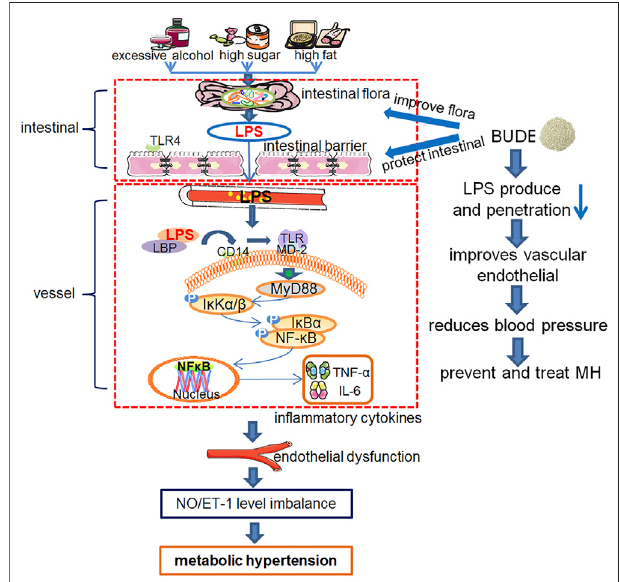
FIGURE 9 | Experiment protocol blueprints. This schematic diagram showsthemechanismofover-consumptionofalcohol,andhighsugarandfat diets (ACHSFDs) leading to metabolic hypertension (MH). BUDE regulated intestinal fl ora and improved the intestinal barrier, so as to reduce LPS production and in fi ltration into the blood circulation, inhibited the activation of the enteric-origin LPS/TLR4 pathway, and improved vascular endothelial function, thereby improving